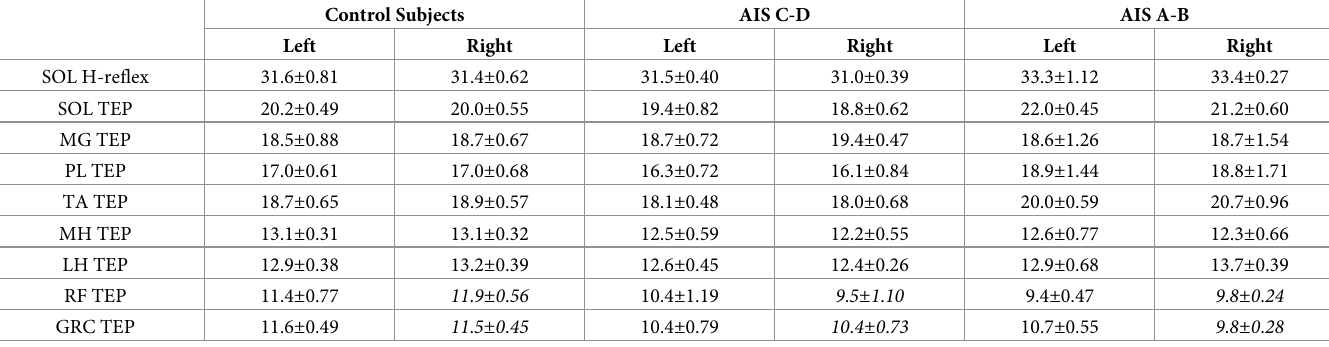
Table 2. Transspinal evoked potential (TEP) onset latency (ms) in individuals with and without spinal cord injury (SCI). Control Subjects AIS C-D AIS A-B Left Right Left Right Left Right